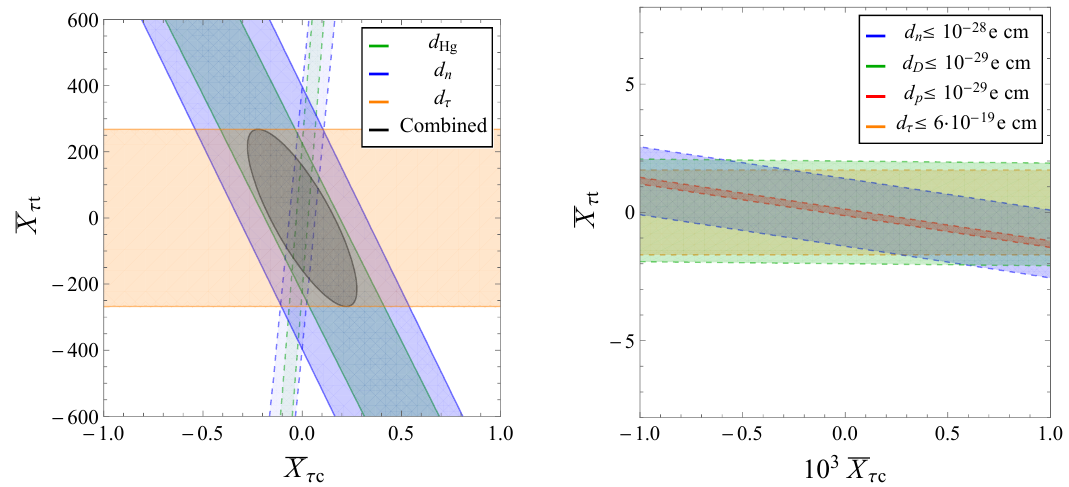
Figure 8 . Left panel: constraints from various EDM experiments in the (cid:22) X (cid:28)c - (cid:22) X (cid:28)t plane. The dark ellipse is the combined allowed region. Solid (dashed) lines indicate the constraints for g c ( g c = m s g s ). Right panel: constraints using expected sensitivities on neutron, proton, deuteron, T T m c and (cid:28) EDM experiments using g c = T